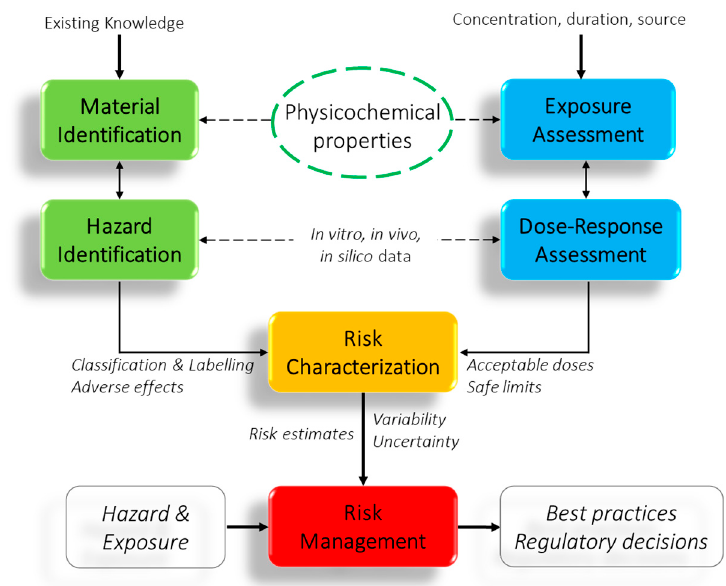
Figure 1. Physicochemical properties in the context of risk assessment (adapted from [25]).